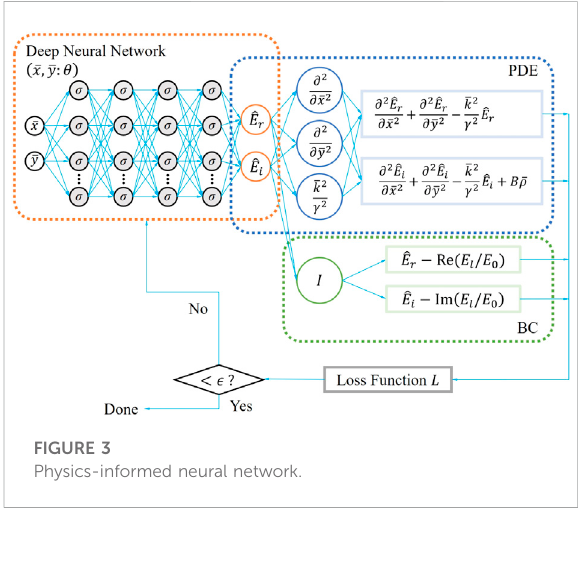
FIGURE 3 Physics-informed neural